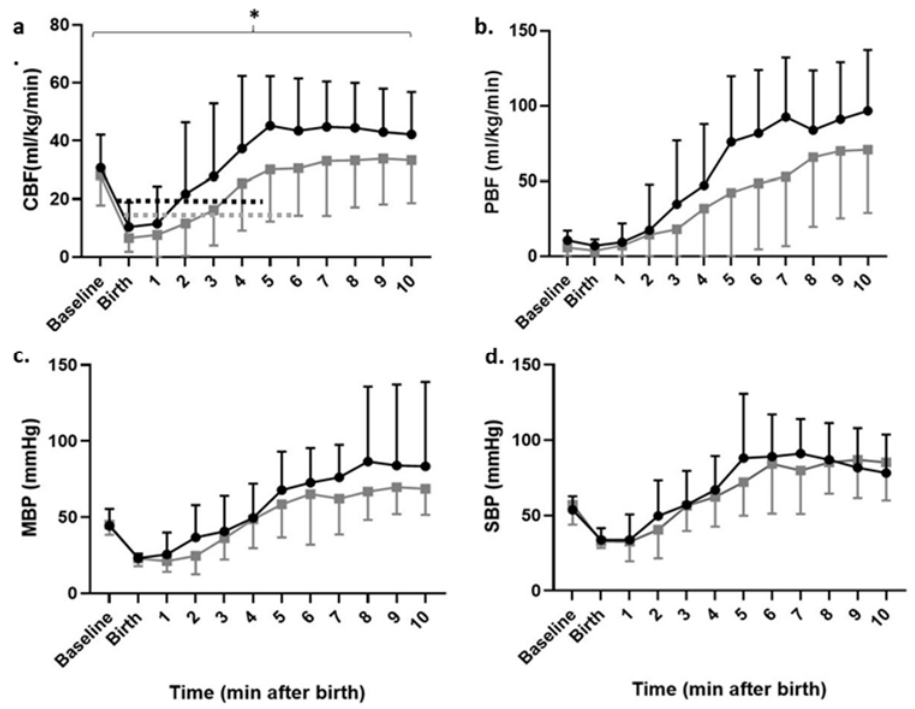
Figure 4. Post resuscitation hemodynamics in the first 10 min after birth based on the timing of cord clamping: ( a ) carotid blood flow, ( b ) pulmonary blood, ( c ) mean blood pressure and ( d ) systolic blood pressure. Data are represented as mean ± SD. * p < 0.05 repeated measures ANOVA. Black circles: ECC. Grey squares: DCC.